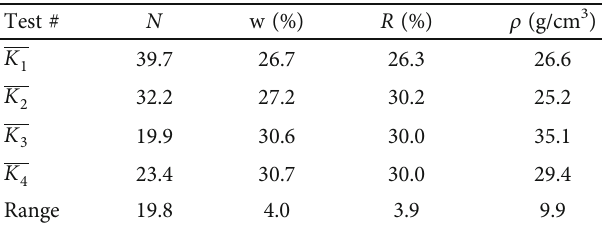
Table 6: Range analysis for internal friction angle.